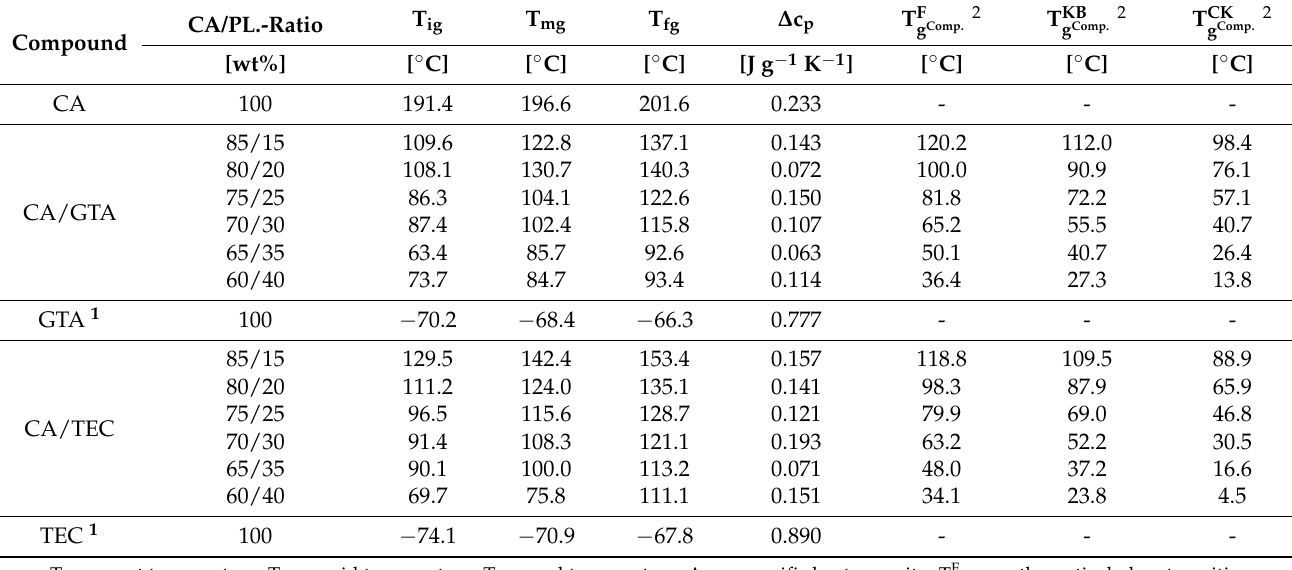
Table 2. Experimental and theoretical values of glass transition temperatures of GTA- and TEC-plasticized cellulose acetate as determined by DSC measurements (second heating run). Compound